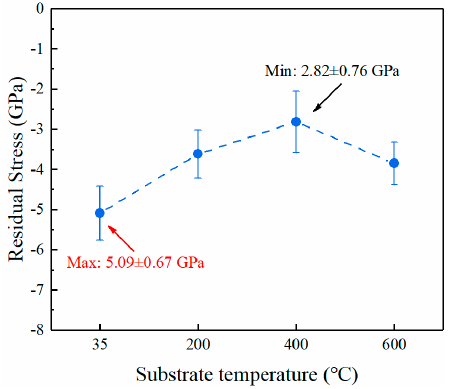
Figure 9. Residual stress of TiN coatings under different substrate temperatures.